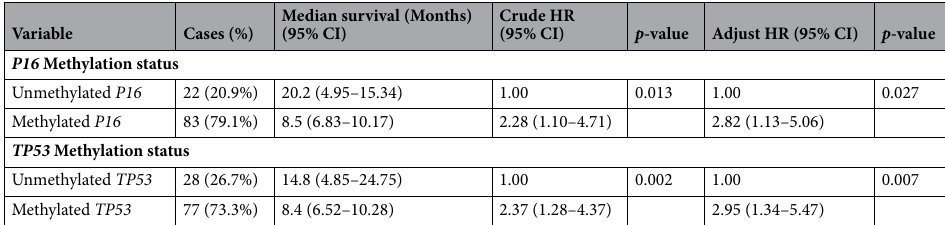
Table 4. Association between methylation status of P16 and TP53 and EC prognosis. Oesophageal cancer; (95% CI): 95% confidence interval, HR hazard ratio, P16 : (cyclin-dependent kinase inhibitor 2A), TP53 : (tumour protein p53), adjust for age, gender, BMI, histology type, grading, TNM state, metastasis, complication and comorbidity by using Cox proportional hazards regression models. p‑value from partial likelihood ratio